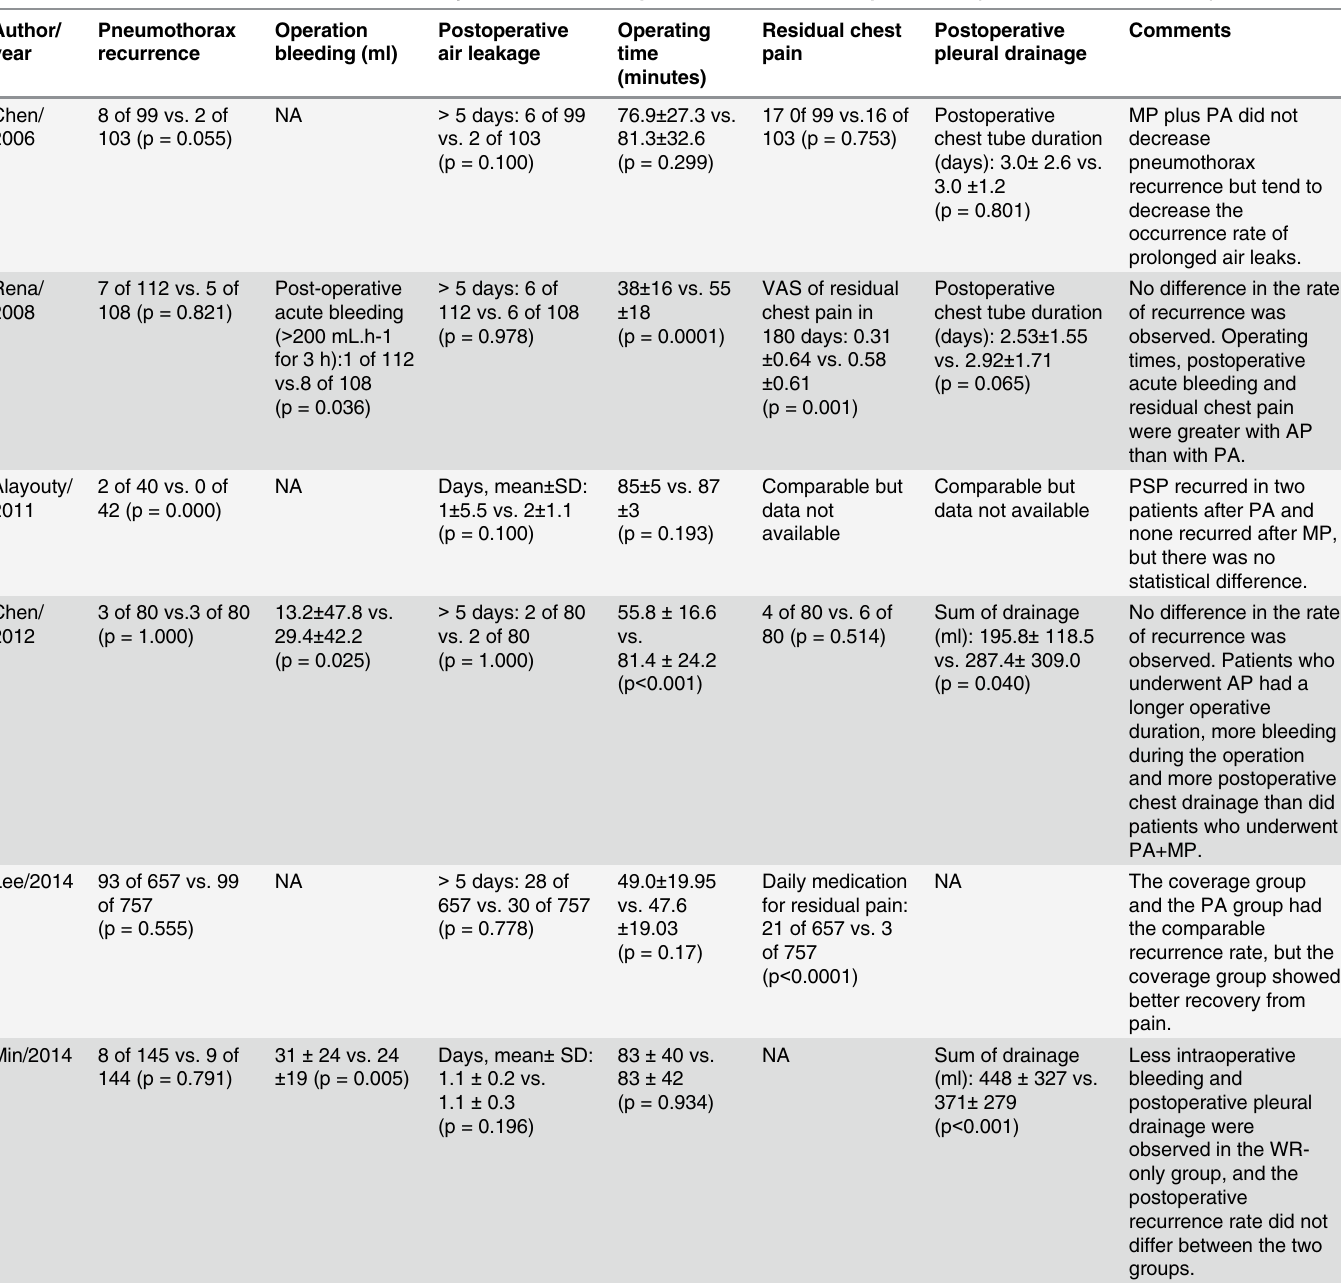
Table 2. Outcome data of studies included in the systematic review of pleural abrasion for PSP prevention (Abrasion versus